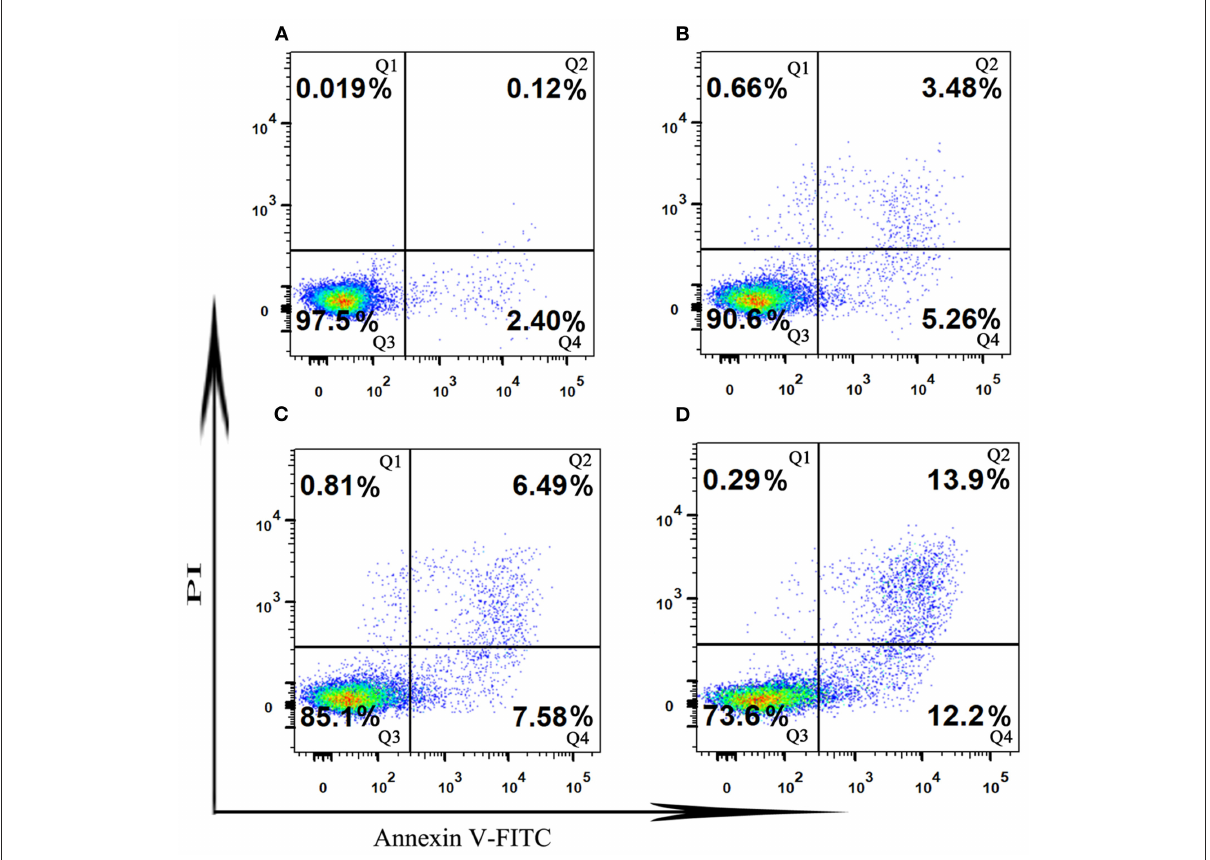
FIGURE8 The cell apoptosis in HT-29 cells exposed to different concentration of SVPS2 (A) 0, (B) 200, (C) 400 and (D) 600 µ g/mL after 24h. Q1–Q4 quadrants represent: Q1, cells stained with PI (necrotic cells); Q2, cell conjugated with Annexin V and stained with PI (late apoptotic cells); Q3, unconjugated with Annexin V and unstained with PI cells (viable cells); Q4, cells conjugated with Annexin V (early apoptotic